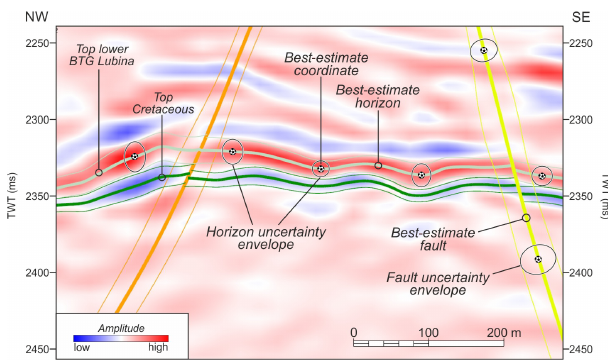
Figure 4. Best-estimate interpretation of the horizons correspond- ing to the top of the lower BTG in the Lubina culmination and the top of the Cretaceous and of two faults, as well as the uncertainty en- velope around the best estimate. This example illustrates the manual uncertainty case; note that the envelope sizes vary along the inter- pretation according to the degree of ambiguity in the seismic